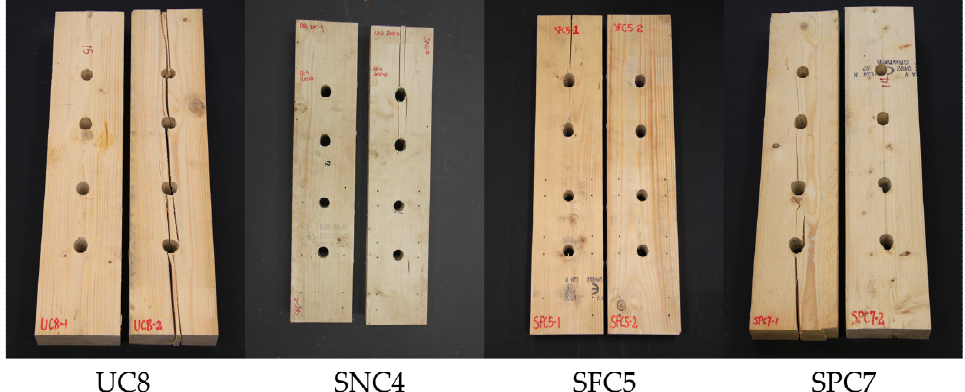
Figure 12. Demonstration of specimen failures in each group.